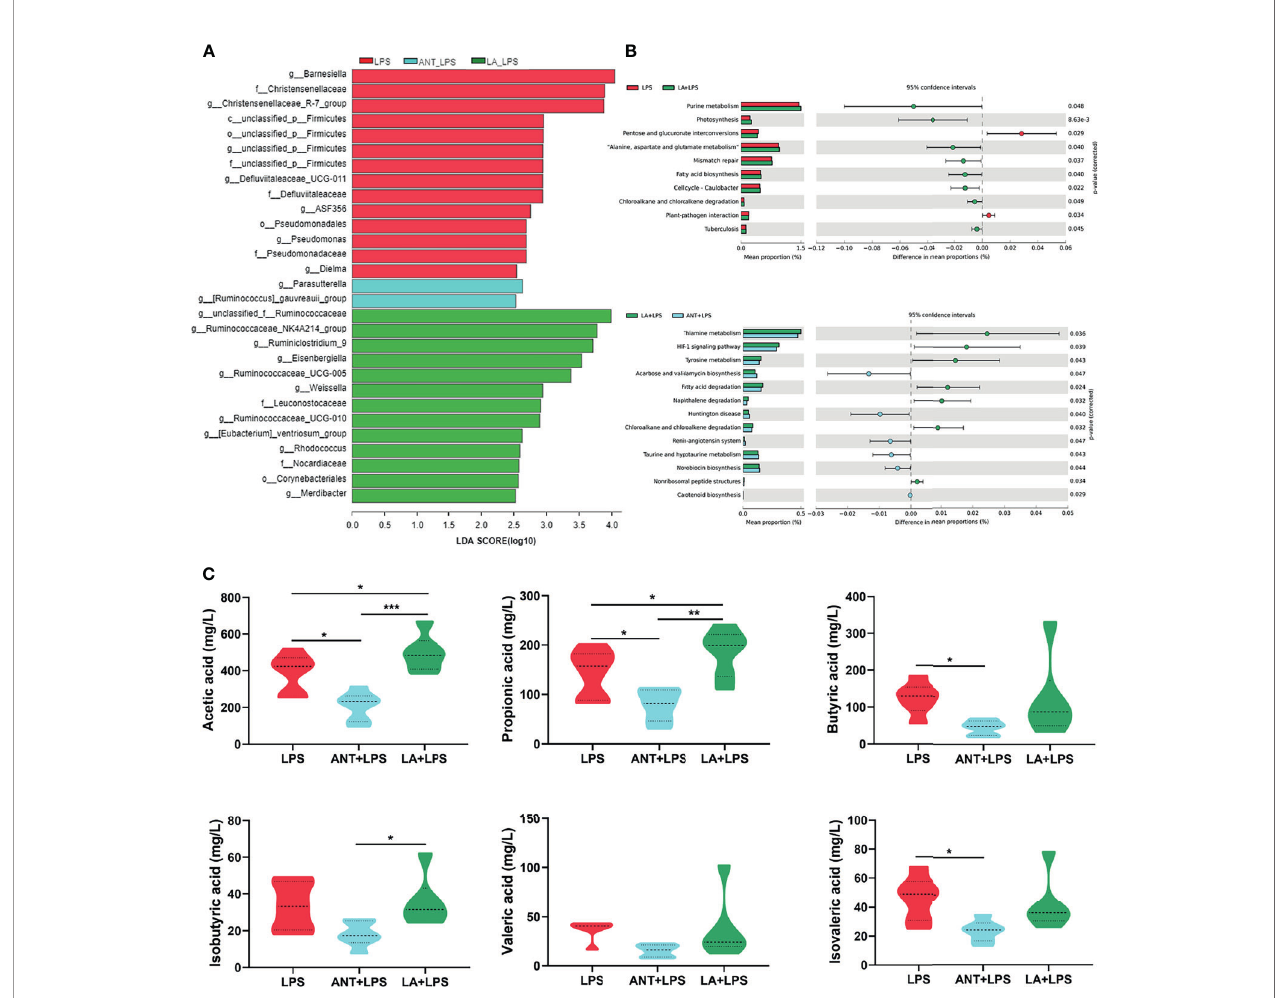
FIGURE 6 | Analysis of taxonomic biomarkers, predicted microbial functions and volatile fatty acid (VFA) production. LPS: fed with a basal diet and injected with 0.5 mg/kg LPS; ANT+LPS: fed with a basal diet supplemented with 75 mg/kg ANT, and injected with 0.5 mg/kg LPS; LA+LPS: fed with a basal diet supplemented with 1000 mg/kg LA, and injected with 0.5 mg/kg LPS. (A) Histogram of Linear discriminant analysis (LDA) scores representing the taxonomic biomarkers by LDA effect size (LEfSe) analysis. LDA score (log10) >2 suggests the enriched taxa in cases, N=8 in each group. (B) Comparisons of gut microbes (LPS vs. LA+LPS, LA+LPS vs . ANT+LPS) by statistical analysis of taxonomic and functional pro fi les (STAMP), N=8 in each group. (C) Violin plots displaying VFA production of the cecal microbiota, N=6 in each group. Data shown as Mean ± SEM were analyzed by one-way ANOVA and Tukey ’ s test. * P < 0.05, ** P < 0.01, *** P <